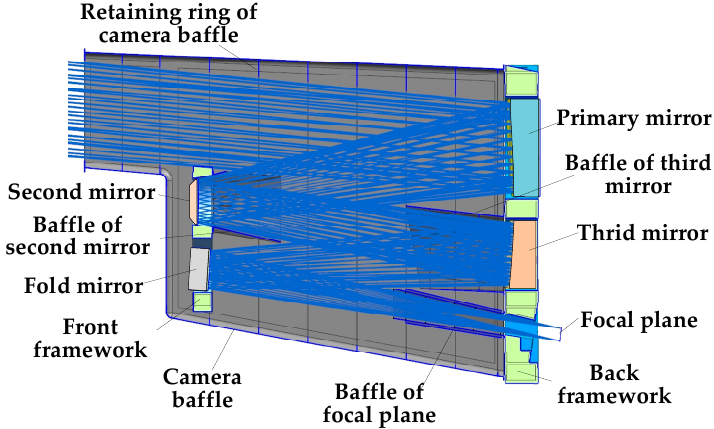
Figure 3. Schematic diagram of the composite stray-light suppression strategy.